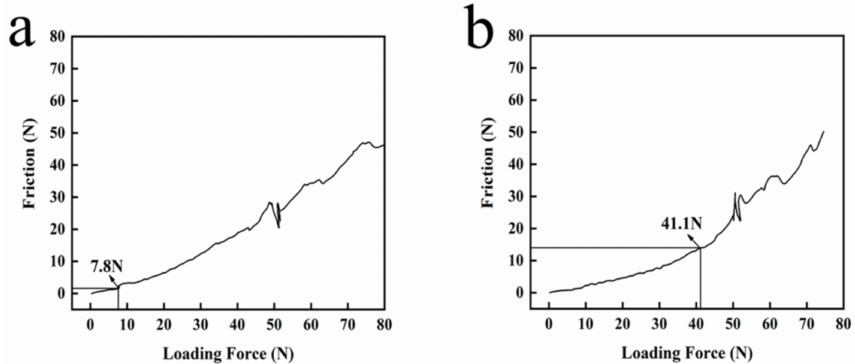
Figure 4. The adhesion force of non-oxidized surface ( a ) and oxidized surface ( b ) with PTFE